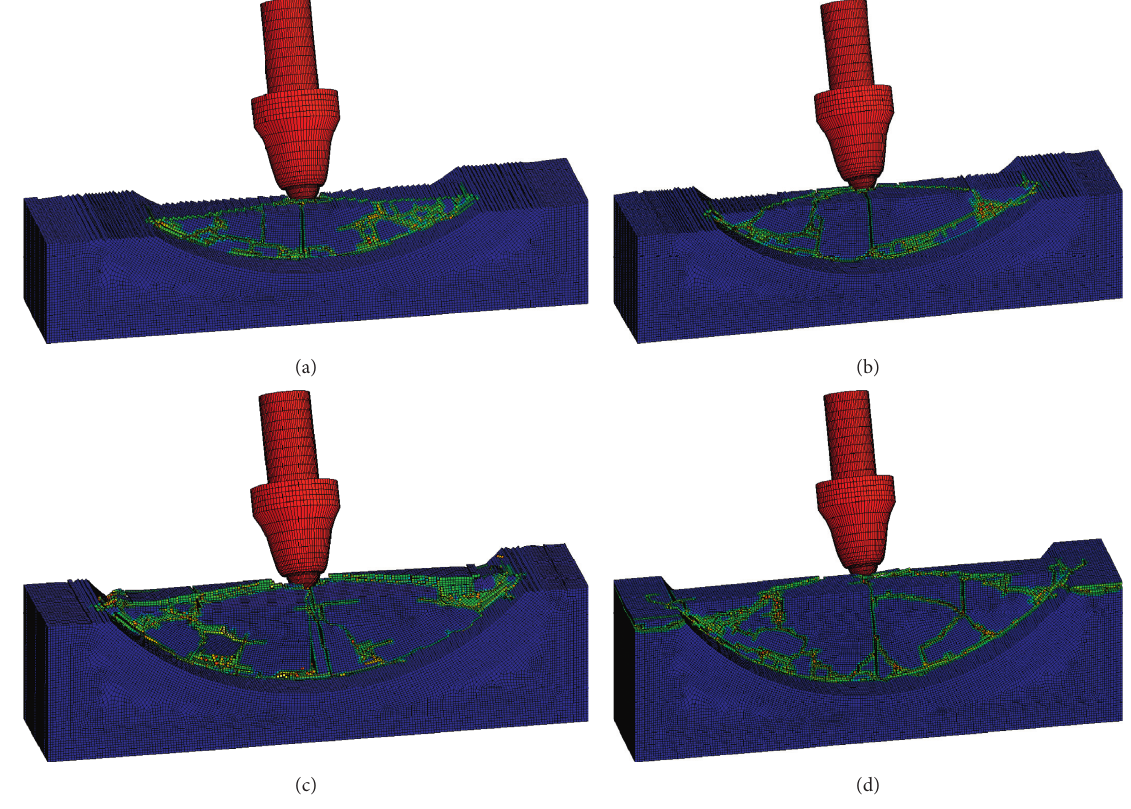
Figure 7: The cutting results with various heights of arc rock plate.